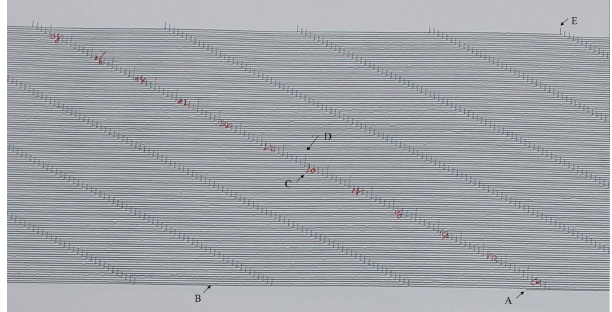
Figure 3. Copy of a part of the normal original record (EW compo- nent) from 09:00LT 1 May to 09:00LT 2 May 2008 at Gaobeidian station. Corresponding letters: A denotes a start record point, i.e., 09:00LT 1 May; B is a normal record line; C indicates a manually marked time, i.e., 20:00LT 1 May; D indicates an automatic marked perpendicular hour line, i.e., 20:00LT 1 May; and E shows an end record point, i.e., 09:00LT 2 May.